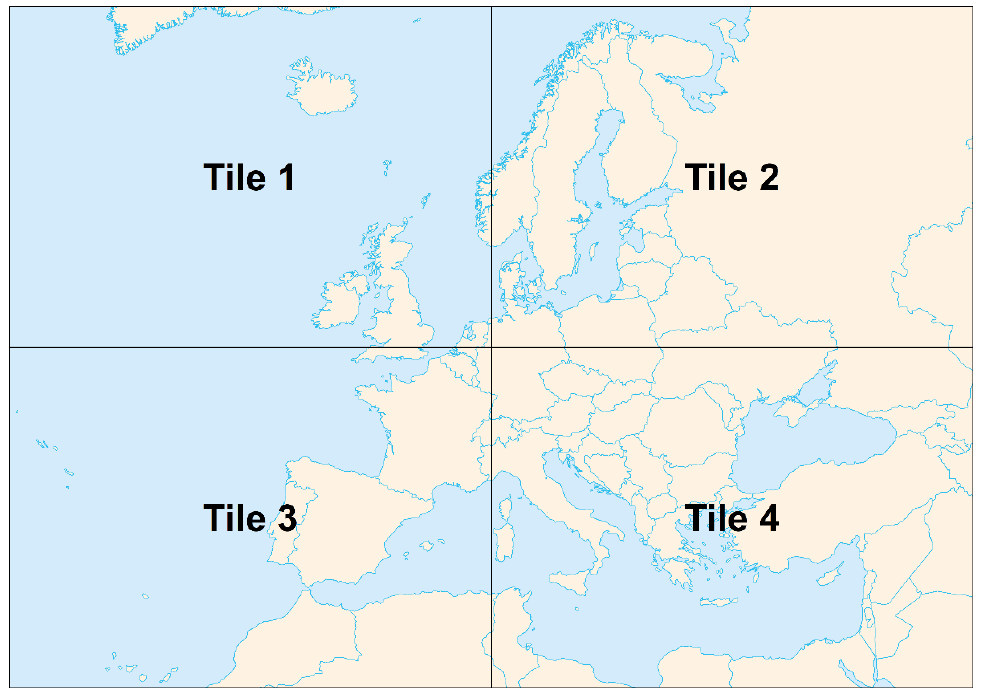
Figure 4. Tiling scheme of the TIMELINE area in ETRS89-extended/LAEA Europe projection. The basis of all Level 3 products is the daily composite of all scenes available on that day. These are first projected into the respective tile. An output pixel size of 1000 m is se- lected, and “nearest neighbor” is selected as the resampling method. Only the “snow_mask” and “snow_quality_flag” layers are projected, with a no-data value of 0 or 255 being set. This gives the “snow_quality_flag” the highest value at this point, which is critical for fur- ther processing, since the processor is looking for the lowest value to fill the day